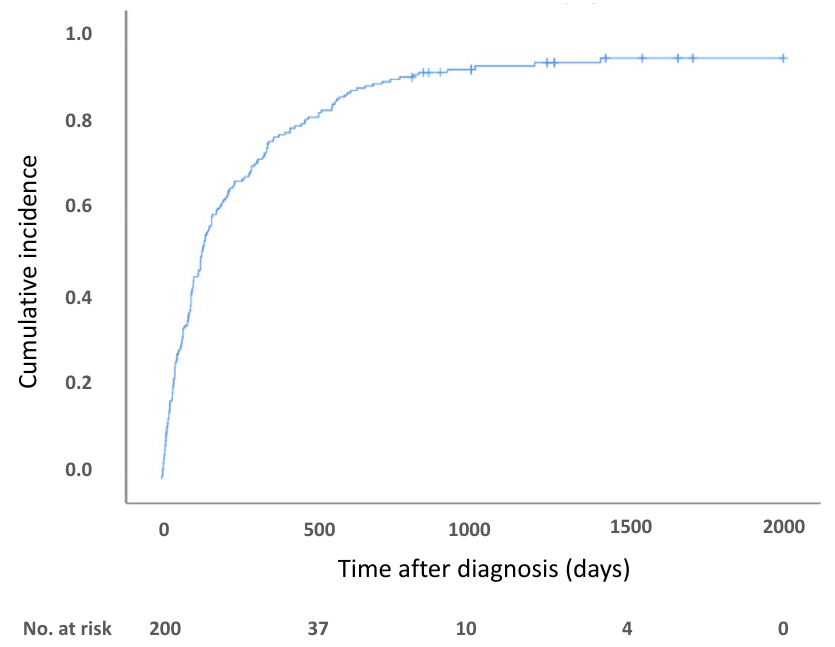
Figure 2. Kaplan–Meier curve-estimated discontinuation of DOAC